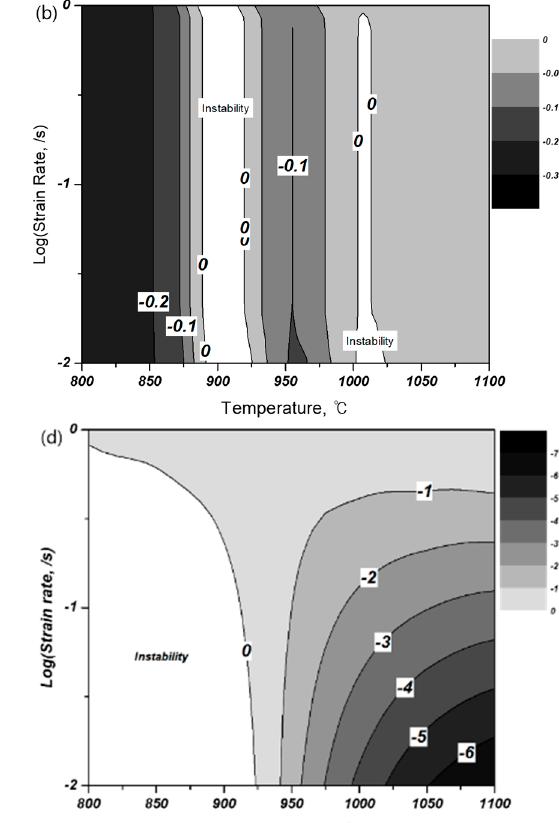
Figure 9. ln(strain rate) variation as a function of inverse temperature.